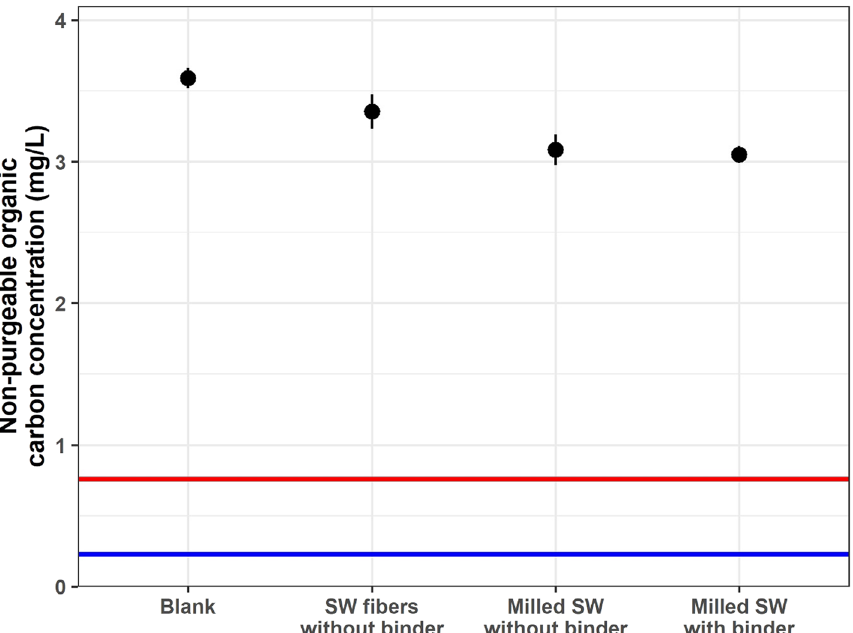
Fig. 2 Non‑purgeable organic carbon contents in the eluates as means and standard errors of three measurements of two experimental eluate replicates (total n 6). Limit of detection (LOD; blue line) and limit of quantification (LOQ; red line) are indicated. Eluates were prepared according to = OECD No. 29 with 100 mg/L sample material and a 7‑day elution